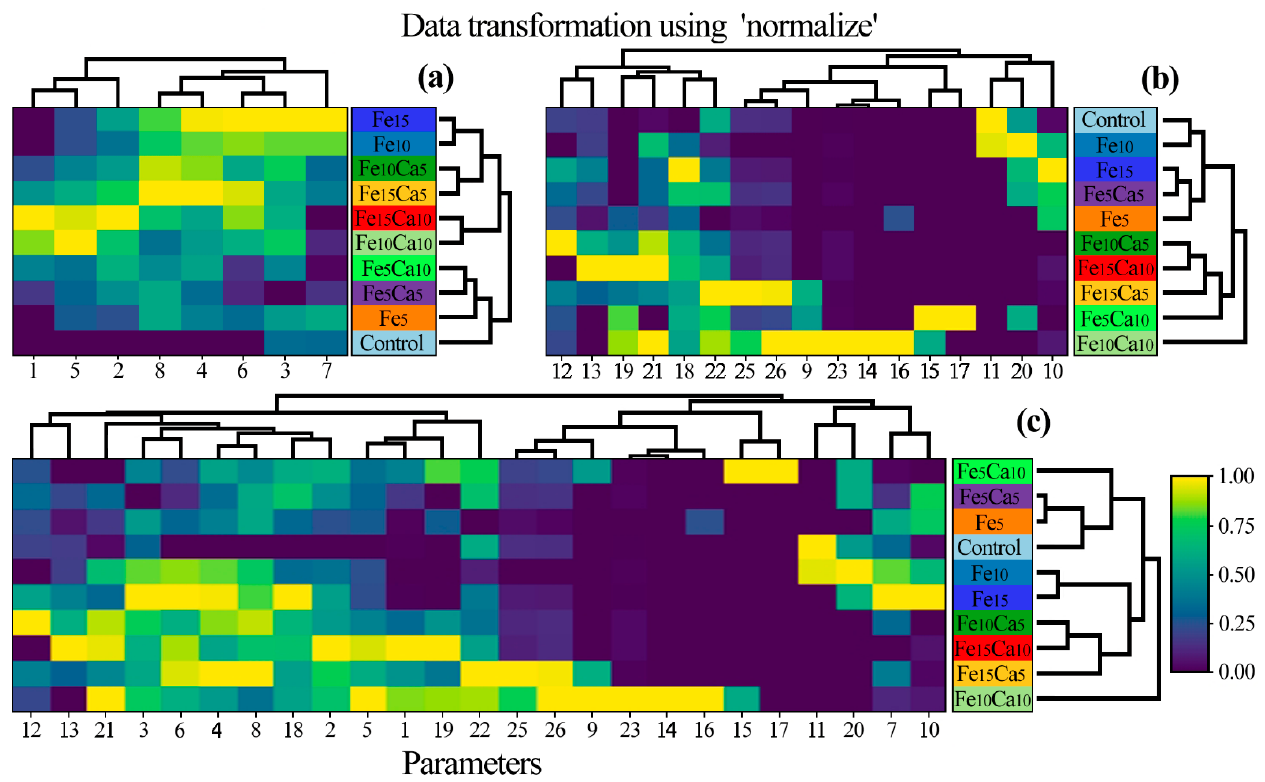
Figure 7. Correlation between particular Pholiota nameko of all experimental systems concerning the content of ( a ) studied elements, ( b ) antioxidants, and ( c ) all studied parameters (Heatmap) in mean values with presentation of a hierarchical tree plot. 1 − Ca; 2 − Fe; 3 − K; 4 − Mg; 5 − Mn; 6 − Na; 7 − P; 8 − S; 9 − protocatechuic; 10 − 4—hydroxybenzoic acid; 11 − catechin; 12 − vanillic acid; 13 − syringic acid; 14 − 2,5 dihydroxybenzoic acid; 15 − caffeic acid; 16 − chlorogenic acid; 17 − sinapic acid; 18 − TP; 19 − quinic acid; 20 − malic acid; 21 − lactic acid; 22 − citric acid; 23 − acetic acid; 24 − fumaric acid; 25 − succinic acid; and 26 − sum of LMWOAs.